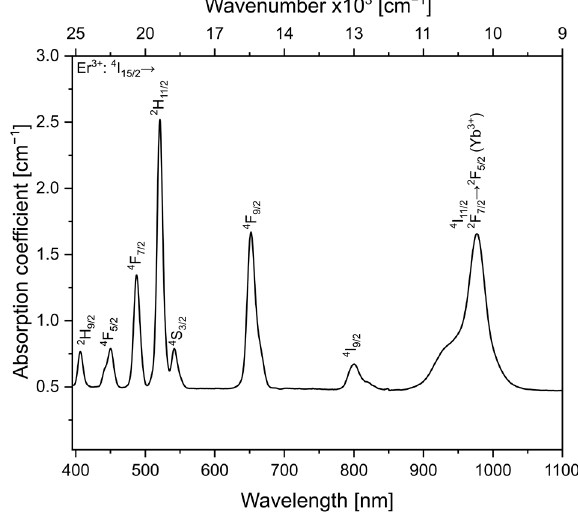
Figure 1. Absorption spectrum for the fluoroindate glass co ‐ doped with Yb 3+ /Er 3+ ions.